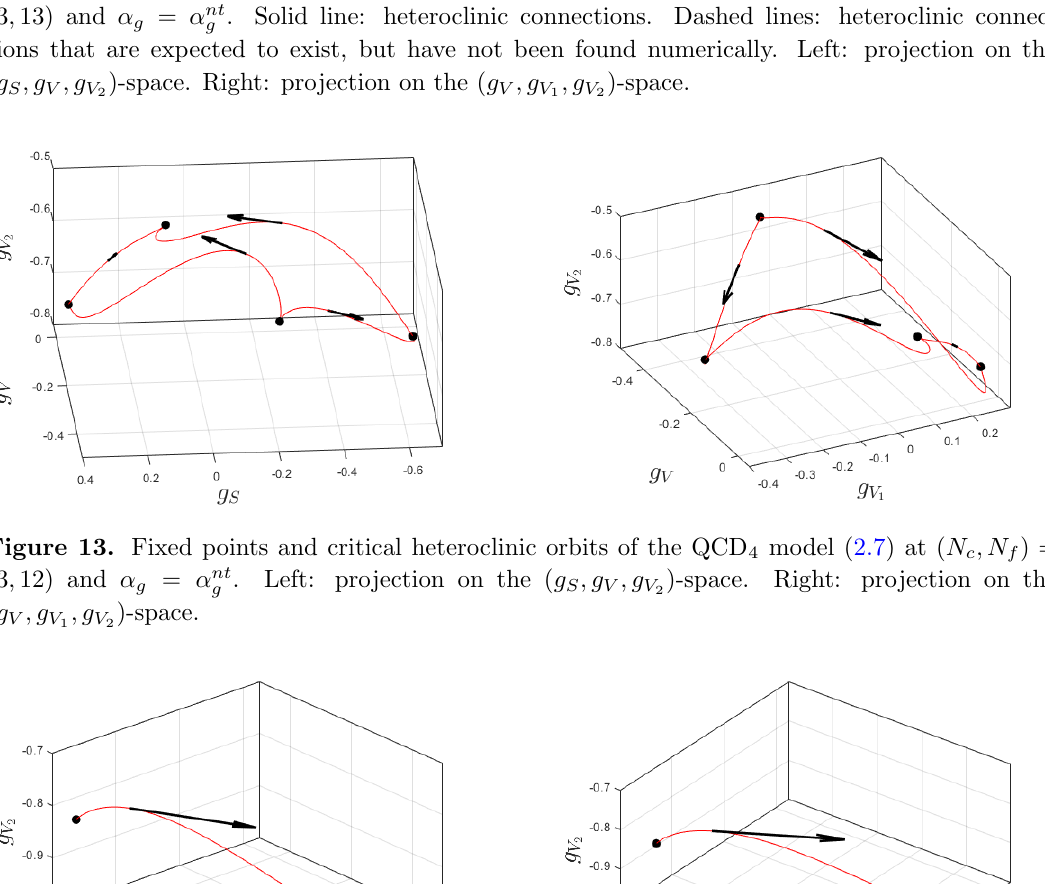
4 model (2.7) at ( N c ; N f ) = ; g V )-space. 1 2